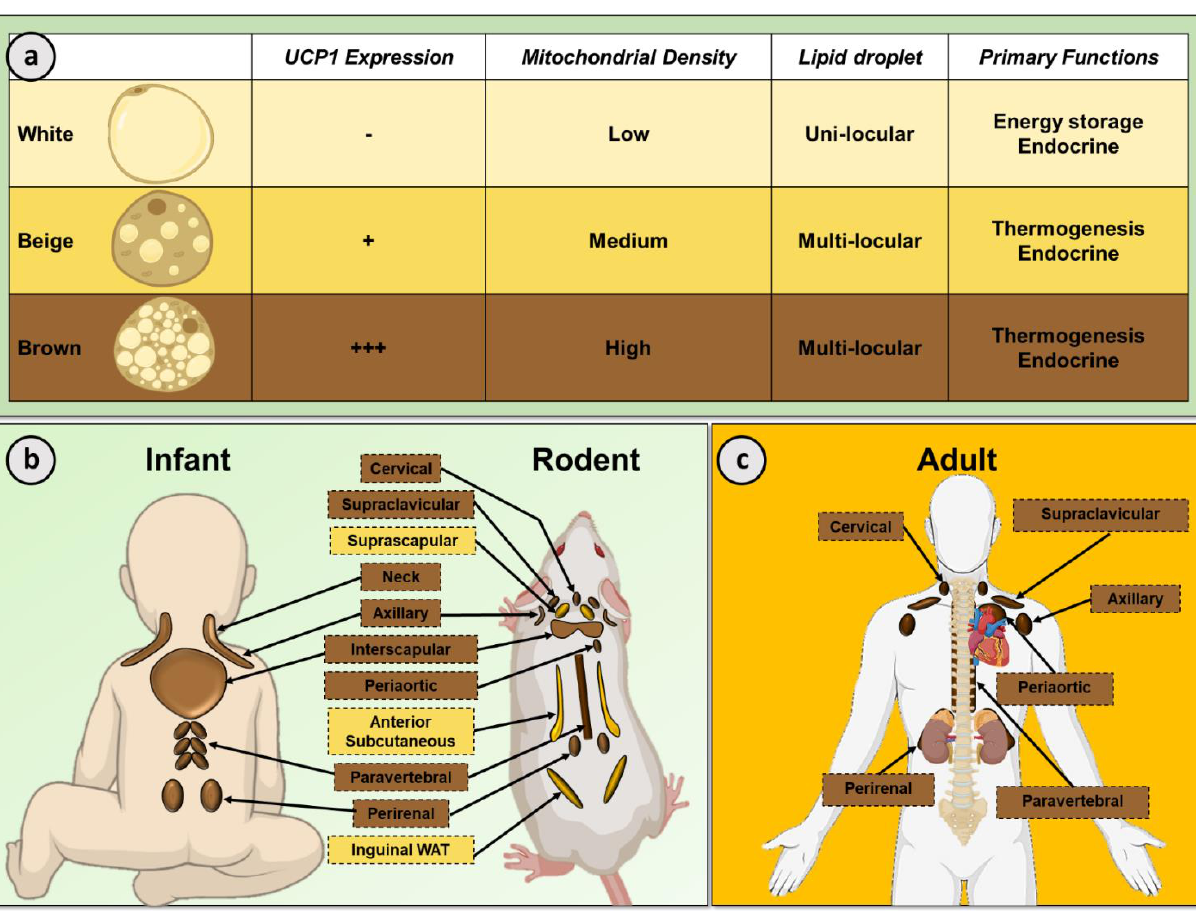
Figure 1. Adipose tissue function and location. ( a ) Brown adipocytes contain many UCP1 positive mitochondria, numerous small lipid droplets and are involved in thermogenesis. In contrast, white adipocytes contain few mitochondria that do not express UCP1 and a single, large lipid droplet for triglyceride storage. Beige adipocytes have an intermediate phenotype between classic brown and white adipocytes. ( b ) BAT is primarily located in the interscapular, neck, axillary and perirenal regions (brown boxes) in the human infant, with smaller depots behind the sternum and along the spine (human newborn) [7 – 9]. The size and composition of rodent BAT differs with age, sex and strain with the largest depot in the interscapular region (classical BAT) and smaller depots in the cervical, supraclavicular and peri-aortic regions. Inducible thermogenic beige adipocytes can form in specific WAT depots such as the suprascapular, anterior subcutaneous and inguinal regions (yellow boxes) [10,11]. ( c ) Adult human BAT is mainly located in the cervical, axillary and supraclavicular regions, with smaller depots observed in the periaortic, perirenal and paravertebral regions. Uncoupling protein 1 (UCP1), brown adipose tissue (BAT), white adipose tissue (WAT).